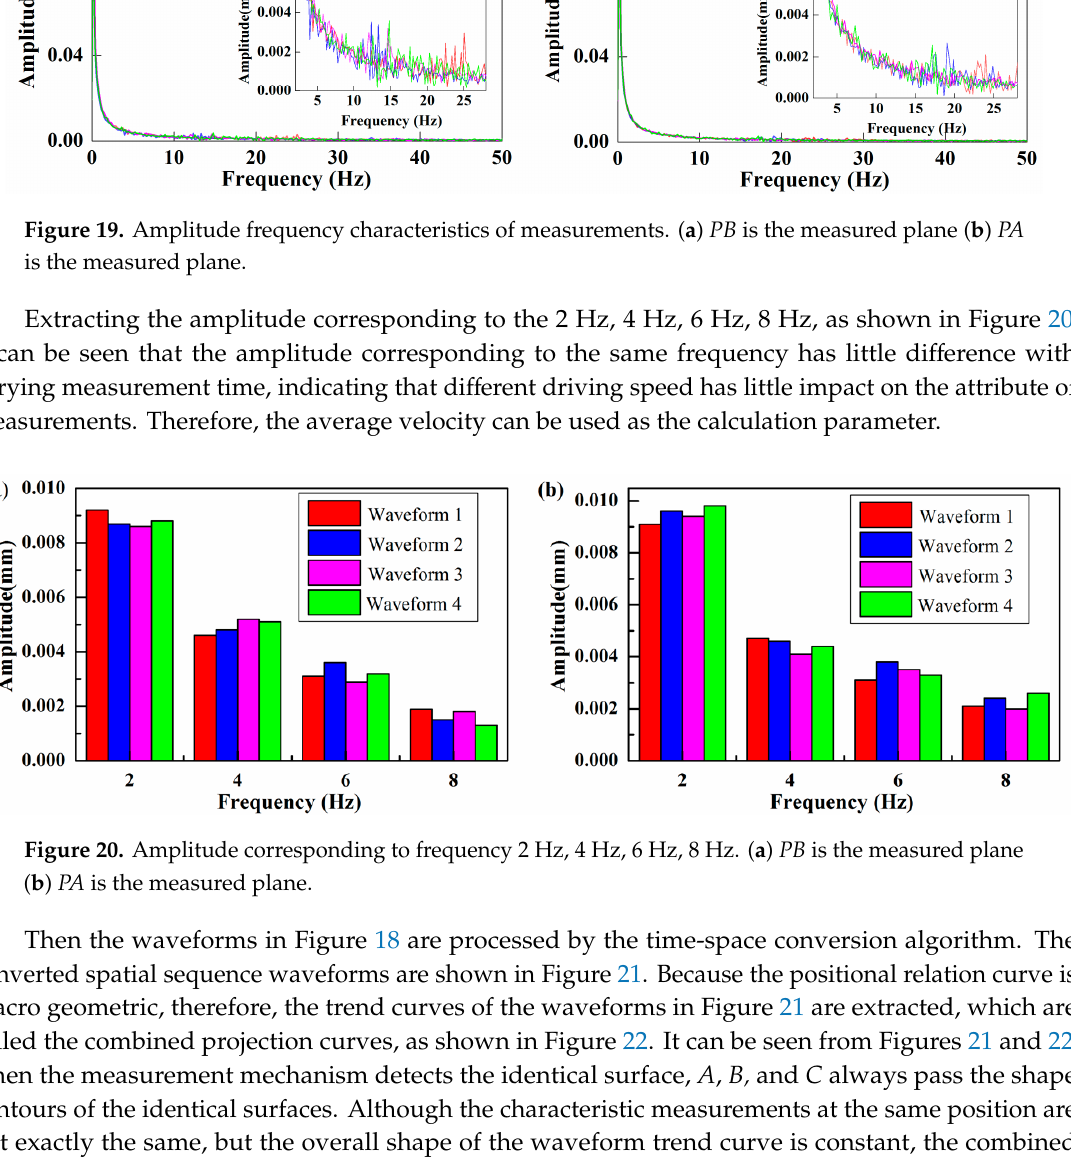
Figure 21. Combined projection waveforms of spatial sequence ( a ) PB is the measured surface. ( b ) PA is the measured surface.